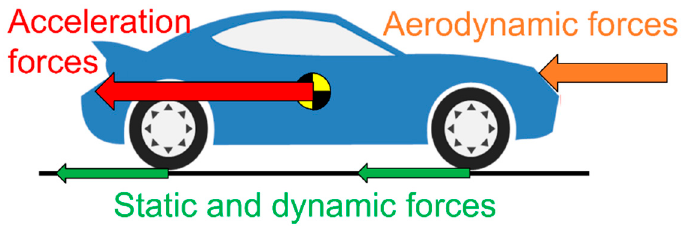
Figure 3. Forces applied to the vehicle.